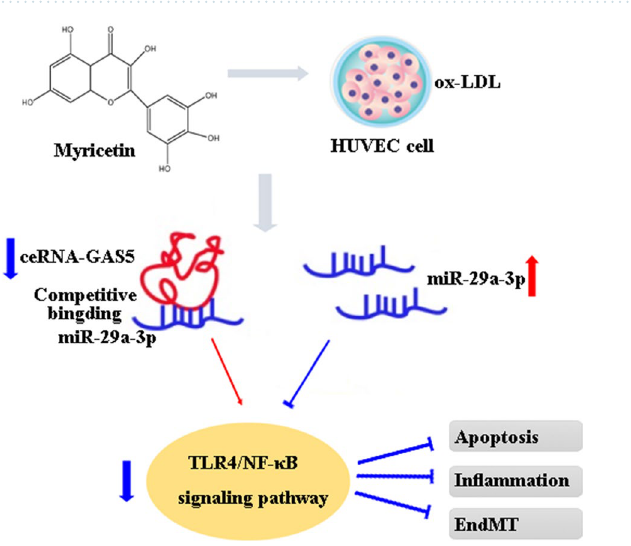
Figure 7. Myr inactivated the TLR4/NF-κB signalling pathway in ox-LDL-treated HUVEC by down- regulating GAS5 or upregulating miR-29a-3p. Western blot analysis of p-p65, p65T, p-IκBα, IκBα and TLR4. * P < 0.05 compared with Control; # P < 0.05 compared with ox-LDL + Myr + NC. & P < 0.05 compared with ox-LDL + Myr + mimic control.